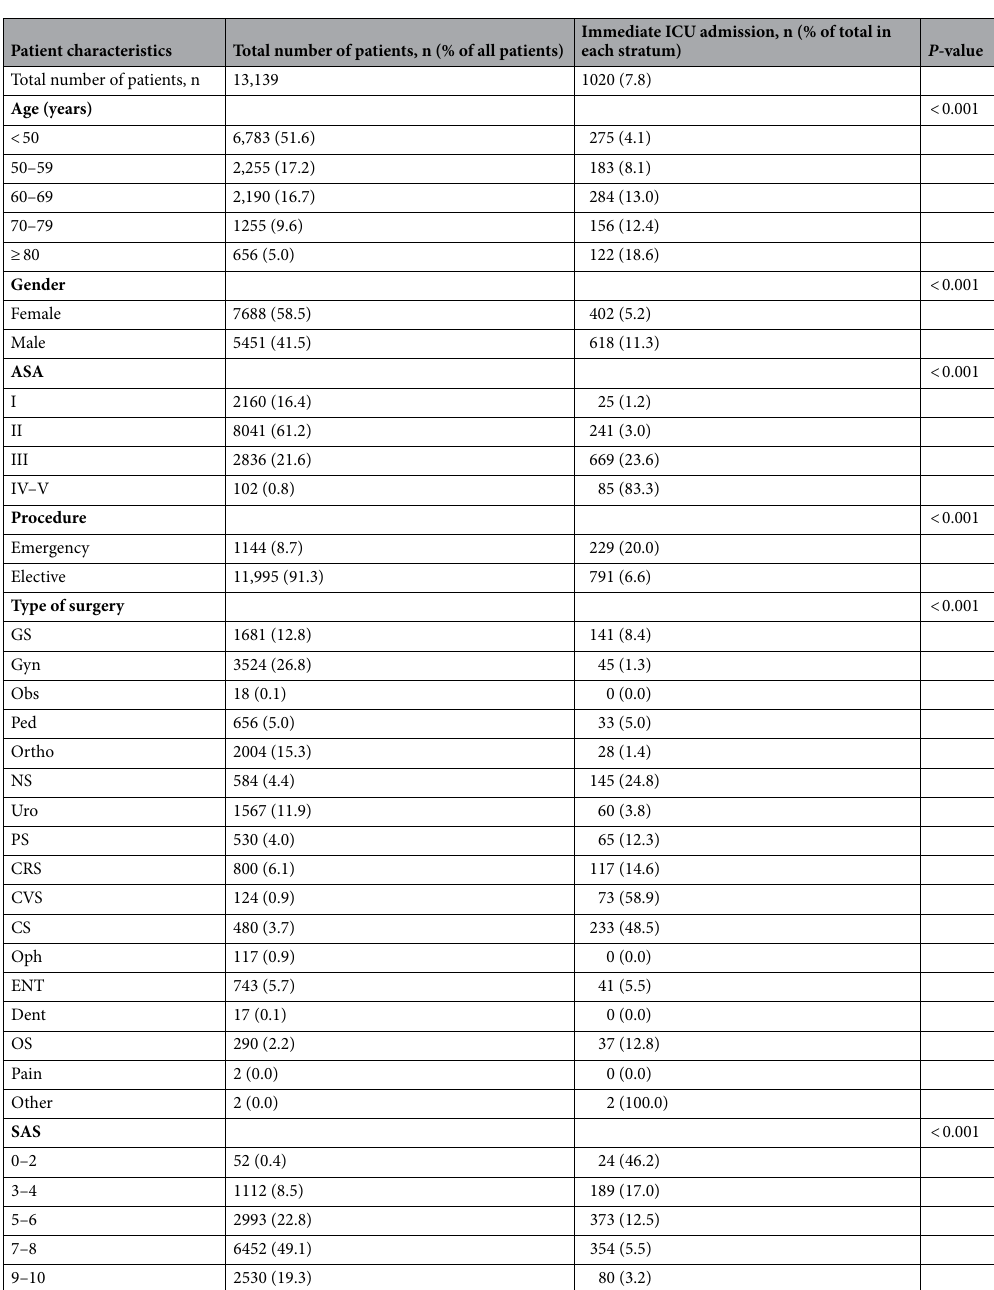
Table 2. Patient characteristics and frequency of admission to the ICU. ICU intensive care unit, ASA American Society of Anesthesiologists, SAS surgical Apgar score, GS general surgery, Gyn gynecology, Obs obstetrics, Ped pediatrics, Ortho orthopedics, NS neurosurgery, Uro urology, PS plastic surgery, CRS colorectal surgery, CVS cardiovascular surgery, CS chest surgery, Oph ophthalmology, ENT otorhinolaryngology, Dent dentistry, OS oral